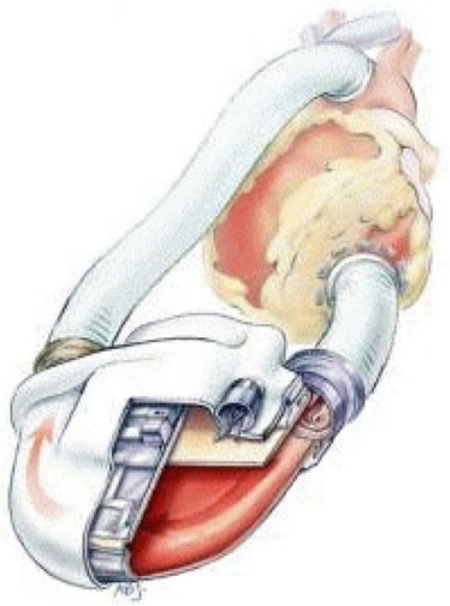
Figure 1 Novacor.